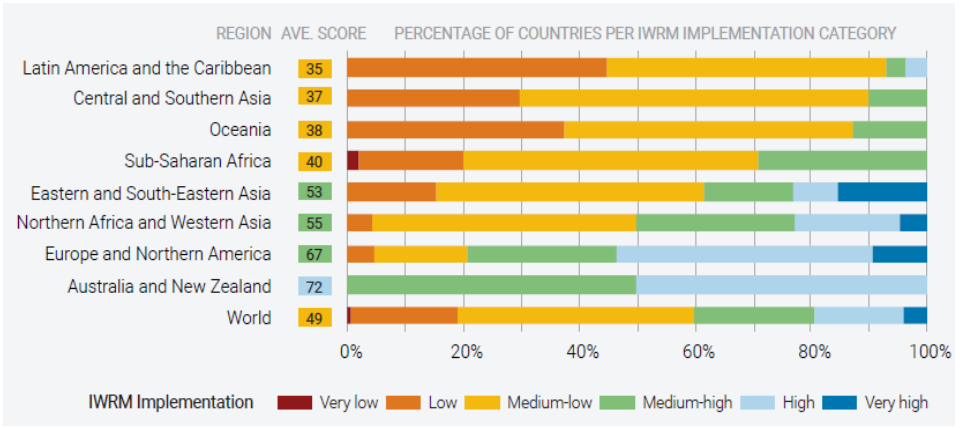
Figure 5. Regional 6.5.1 score averages and score distribution [36].